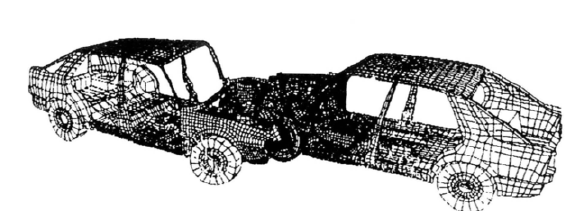
FIGURE 13 Automobile crash simulation with LS-DYNA3D. Adapted from Hallquist